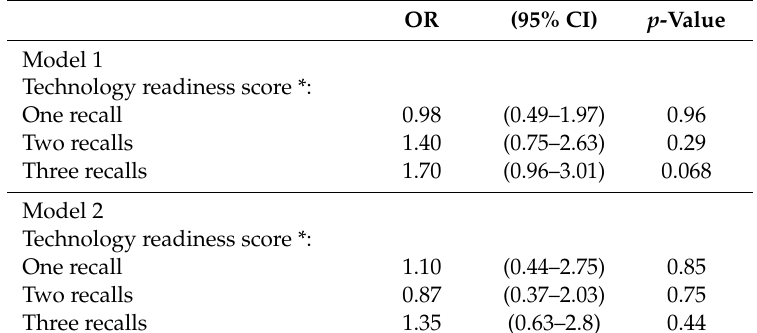
Table 3. Multinomial logistic regression analysis of TR scores in relation to the number of online recalls